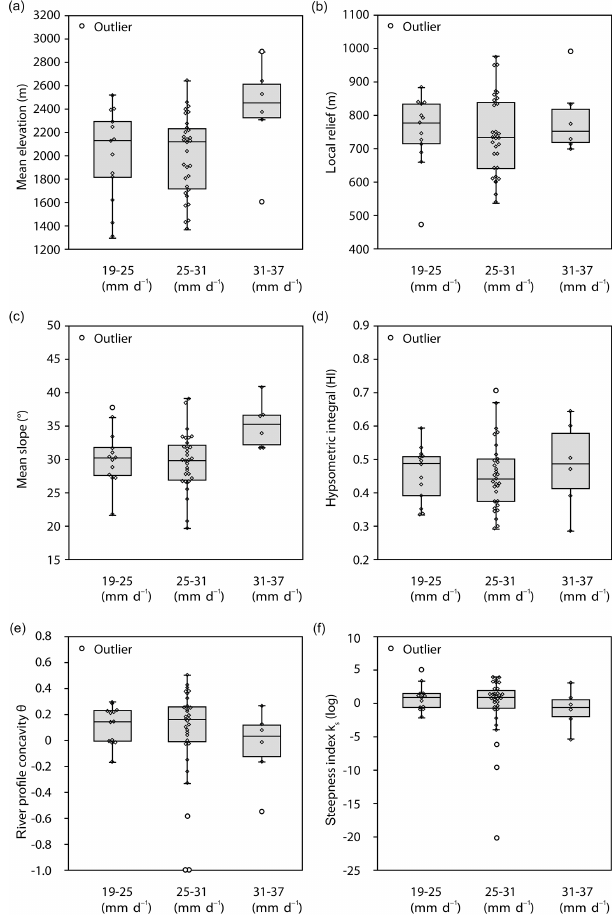
Figure 12. Boxplots of the topographic variables grouped accord- ing to the intensity of precipitation, expressed by the 90th percentile of total daily